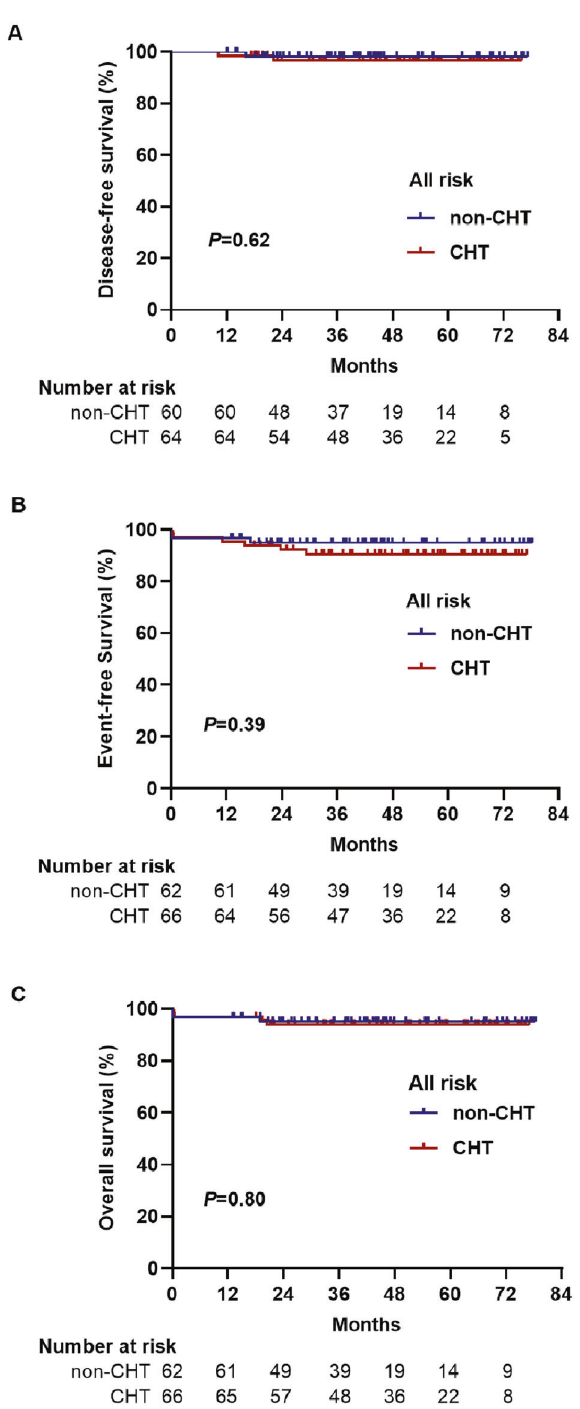
Fig. 3 Survival outcomes for all APL patients. A Disease-free survival. B Event-free survival. C Overall